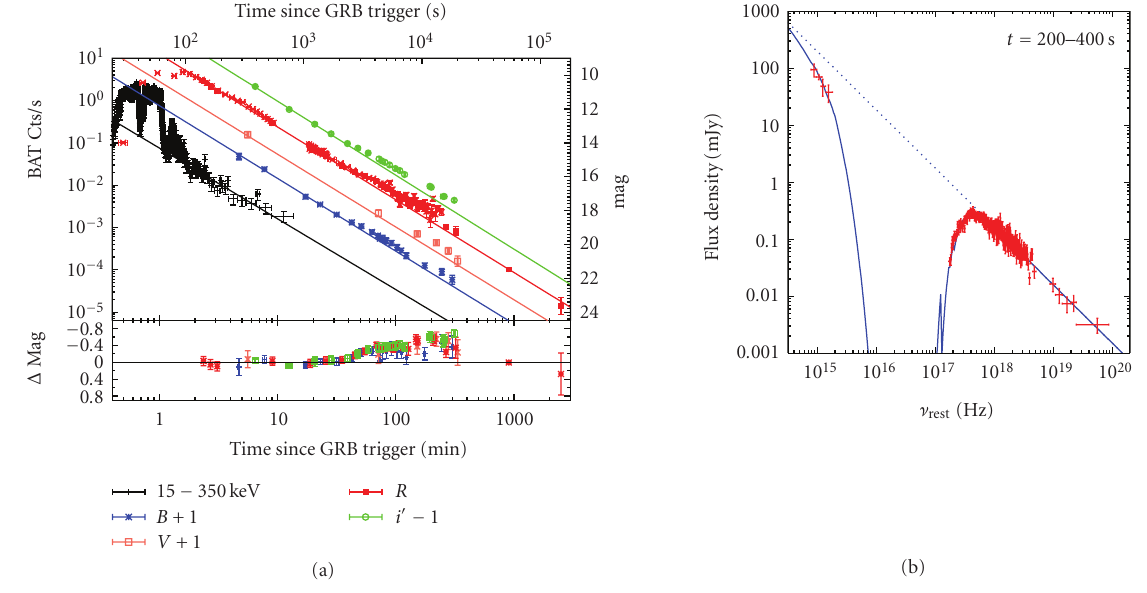
Figure 7: (a) γ -ray (black) and optical BVRi (cid:3) (colour) light curves of GRB 061007 all decaying with a steep power-law index α ∼ 1 . 7 from 137 seconds to ∼ 10 6 seconds. Despite its optical brightness ( R ∼ 10.3 mag at 137 seconds), a reverse-shock optical flash is ruled out (adapted from [23, 60]). (b) Early-time (200–400 seconds) broad-band optical to γ -ray SED fitted with single absorbed power law β (opt-X- γ ) = 1.02 ± 0.05 and rest-frame extinction A = 0 . 48 ± 0 . 19 mag (from V (SMC)